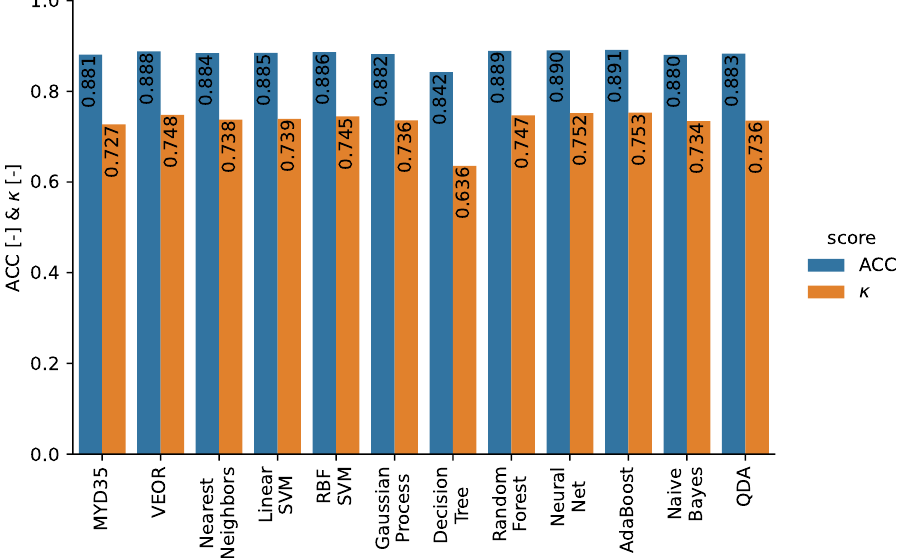
Figure 7. Comparison of classifier performance for cloud discrimination over water surfaces using MODIS spectral measurements collocated with the CALIOP/CPR reference cloud mask. MYD35 denotes AQUA MODIS collection 6 cloud mask